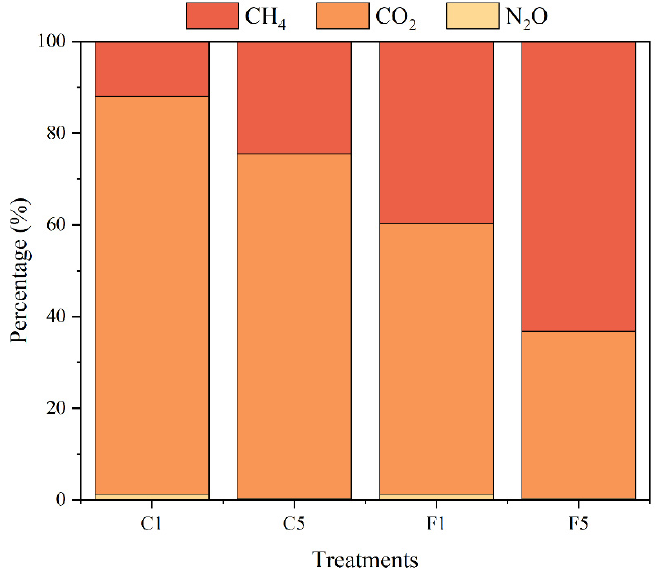
Figure 4. GWP percentage of N 2 O, CO 2 , and CH 4 in each treatment. C1: controlled irrigation with